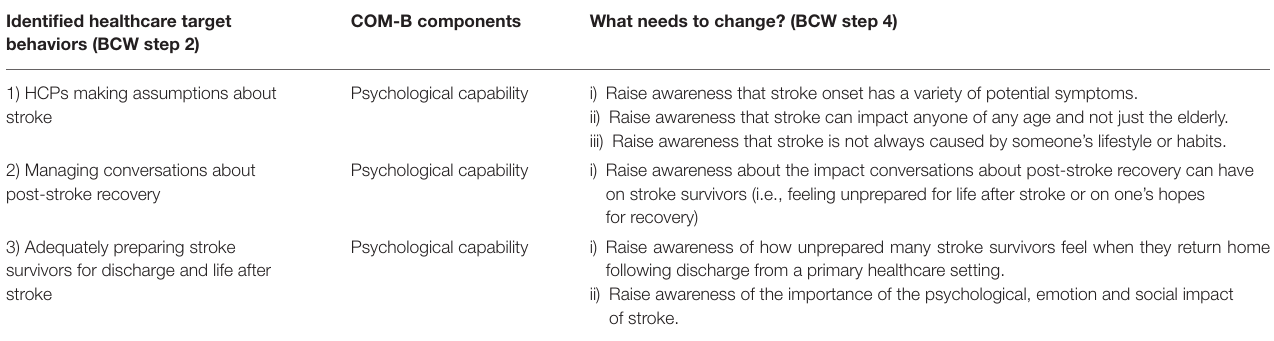
TABLE 4 | Discover stage: what healthcare behaviors need to be changed when interacting with stroke survivors and how to influence change (BCW step 2 and 4). Identified healthcare target behaviors (BCW step 2)